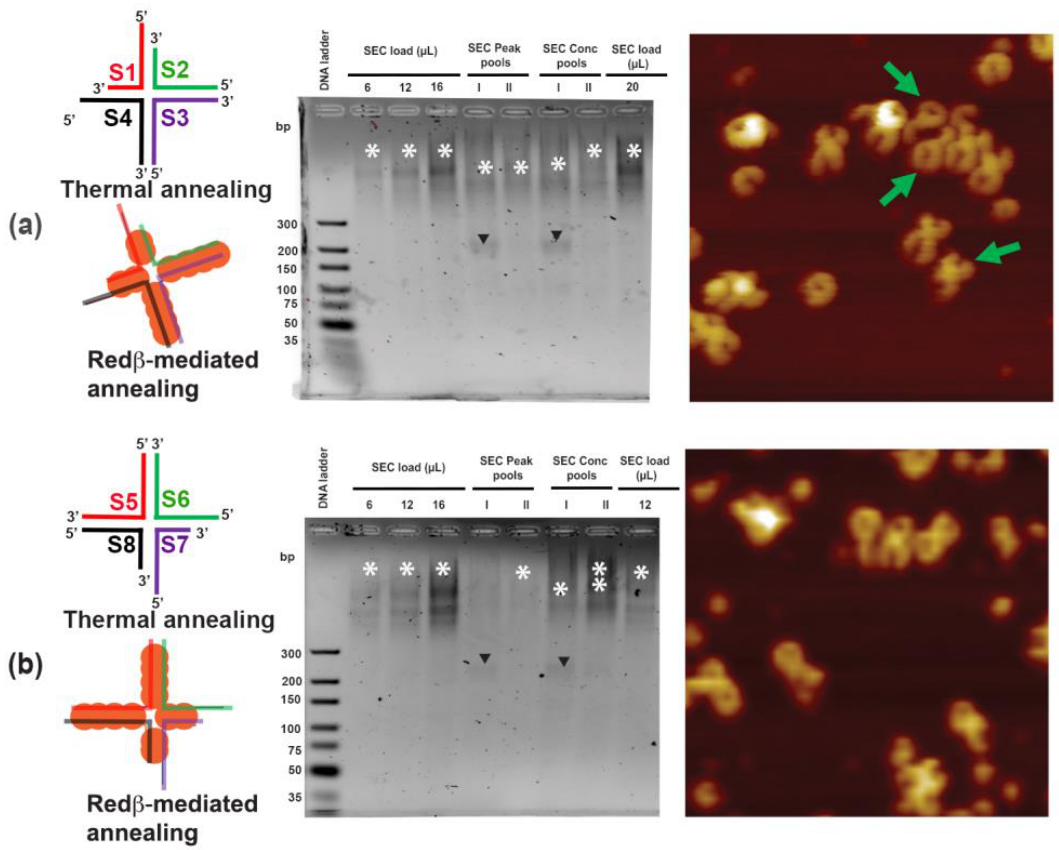
SEC and fractions from each peak’s summit were pooled and analyzed along with load and concentrated samples by agarose gel electrophoresis (see Figure 6). For the S1S4 and S5S8 designs, the SEC loads show the presence of HJ species (see asterisks in the corresponding lanes in Figure 6). Pooled and concentrated Peak I fractions show the presence of free DNA substrates (black arrowheads), while the Peak II samples show complete saturation (asterisks). The AFM image of the S1S4 HJ structures in Figure 6a shows highly concentrated single species with sticky ends at two of the arms. Since the S2S3 and S3S4 arms have lengths of 44 nucleotides, many S1S4 HJ structures have an almost closed ring at one side and a half-ring at the other. Nevertheless, a certain variability of HJ structures is observed and can be attributed to the presence of di ff erent numbers of Red β monomers. Upon binding with ssDNA, the Red β monomers adhere and grow filaments of multiple lengths. Therefore, an 88 mer ssDNA does not necessarily have to be occupied by precisely eight Red β monomers. If there are only seven monomers on an 88 mer ssDNA instead of eight, the HJ structure will exhibit a slightly di ff erent length and curvature. For instance, there are HJ structures observed with one arm being shorter than the others or even missing completely (highlighted by green arrows in Figure 6), which demonstrates the necessity of enriching the individual species. Even though the individual species of S1S4 and S5S8 were enriched by SEC, there are still plenty of incomplete HJ structures observed in the AFM images in Figure 6 that have only one, two, or three arms.